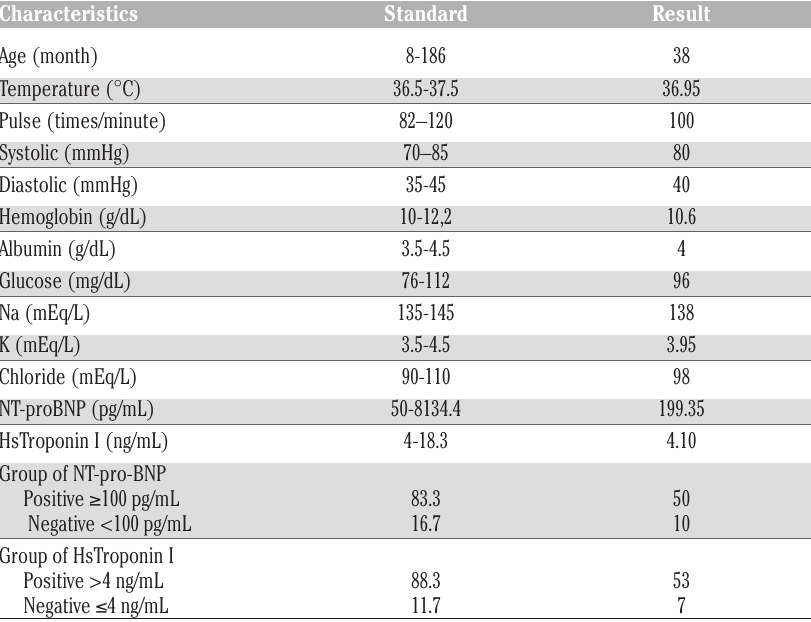
Table 1. Characteristics of subjects and examination